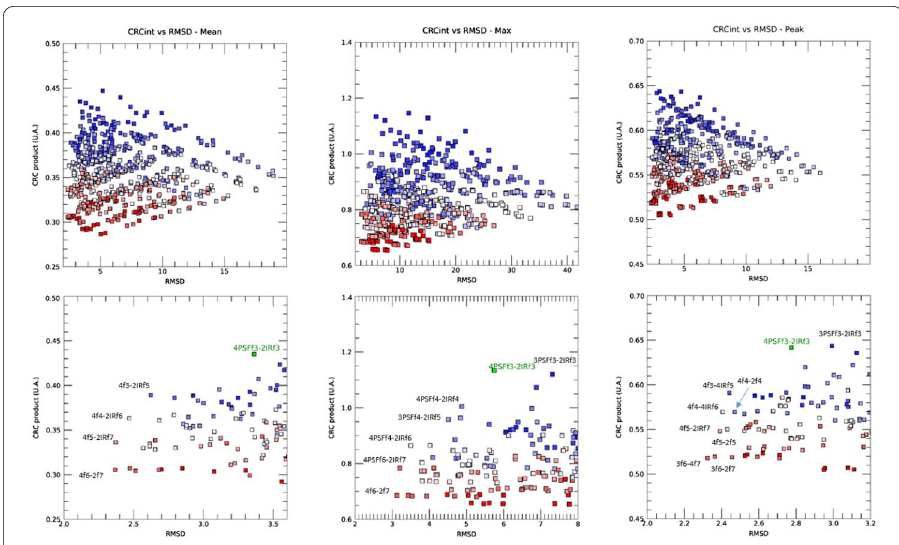
Fig. 4 CRC mean,max,peak product versus RMSD box plot. Each of the 600 pairs of image reconstructions parameters combinations is represented by a box (top row). The color scale from blue to red represents the different level of overall filtration. Dark blue boxes represent combinations with least overall filtration (i.e., 3 mm for both mMR and Signa images), and dark red corresponds to most filtration (7 mm on mMR and Signa images). Bottom row, expanded view at low RMSD to identify candidate image reconstruction parameters for optimization. The solution for best RMSD and CRC is indicated in